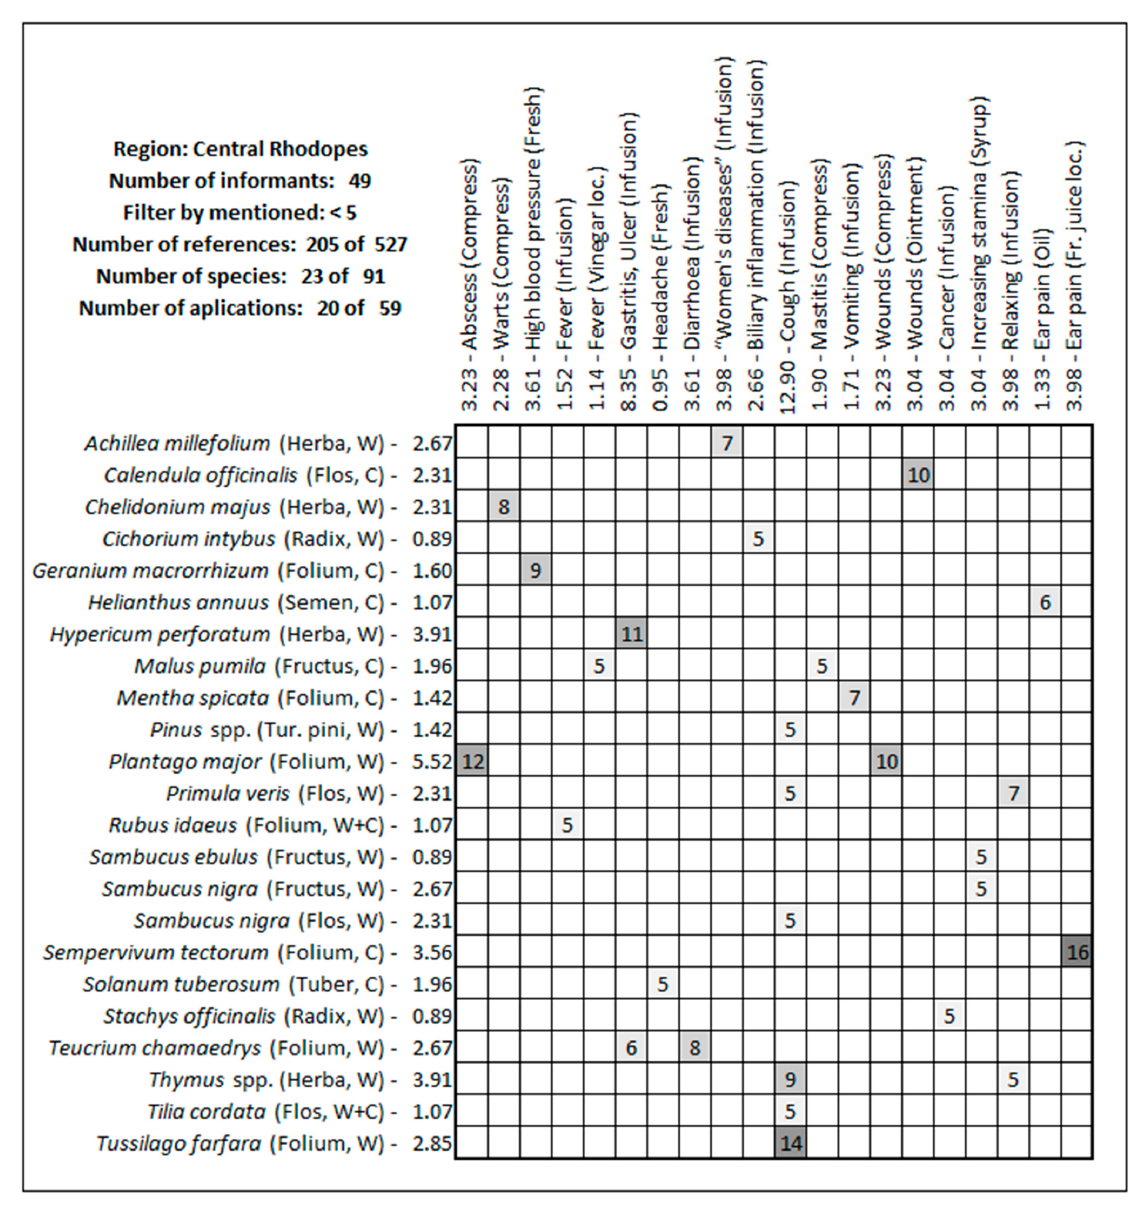
Figure 5. Nomogram of the medicinal plants for human use (at Σ U > 4) in the Central Rhodopes. Legend: abscissa/horizontal axis of the nomograms depicts the conditions for which the informants apply the medicinal plants, as well as the way of processing the plant raw material; ordinate vertical axis shows the medicinal plants Genus species (used part, wild/cultivated)—UV (%).